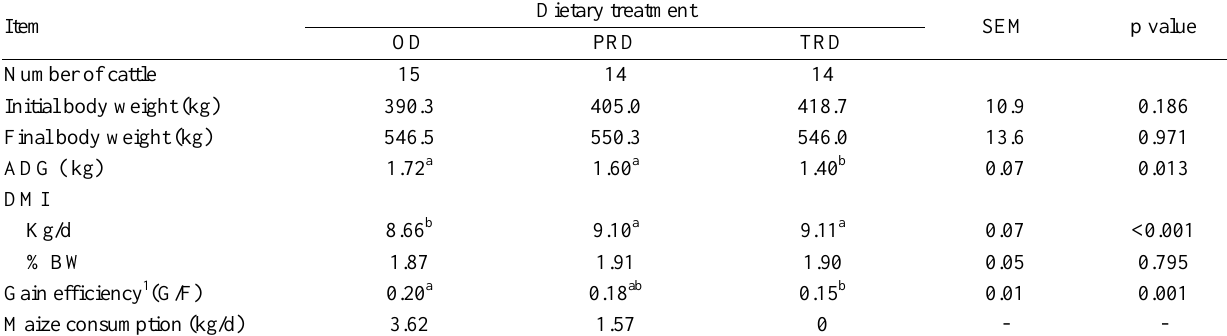
Table 3. Effects of partial or total replacement of maize with alternative feed sources on growth